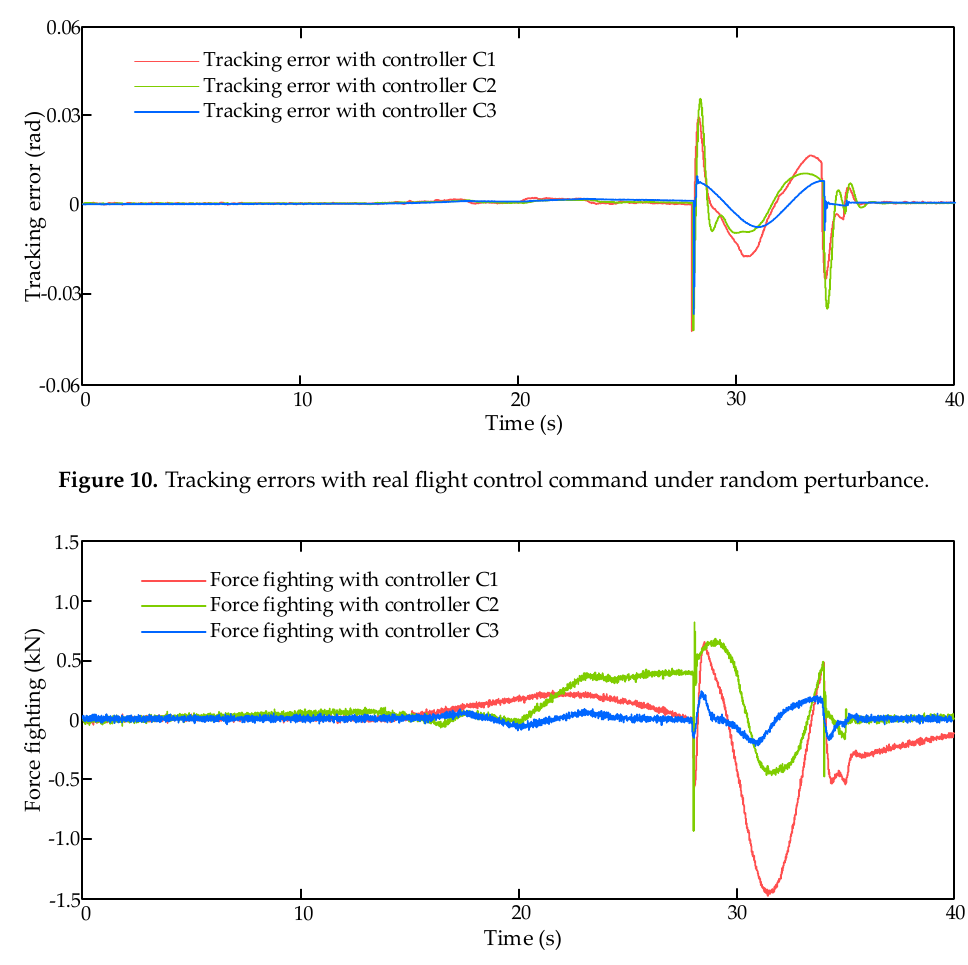
Figure 9. Flight control input command of the hybrid actuation system (HAS).